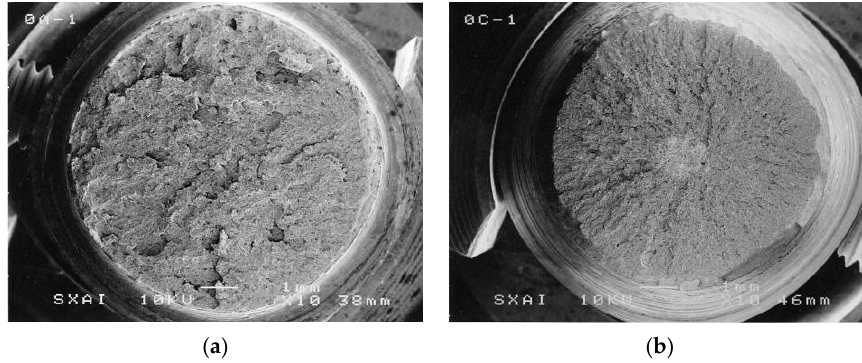
Figure 4. Sample 0A ( a ) and 0C ( b ): isotropic fracture behavior .